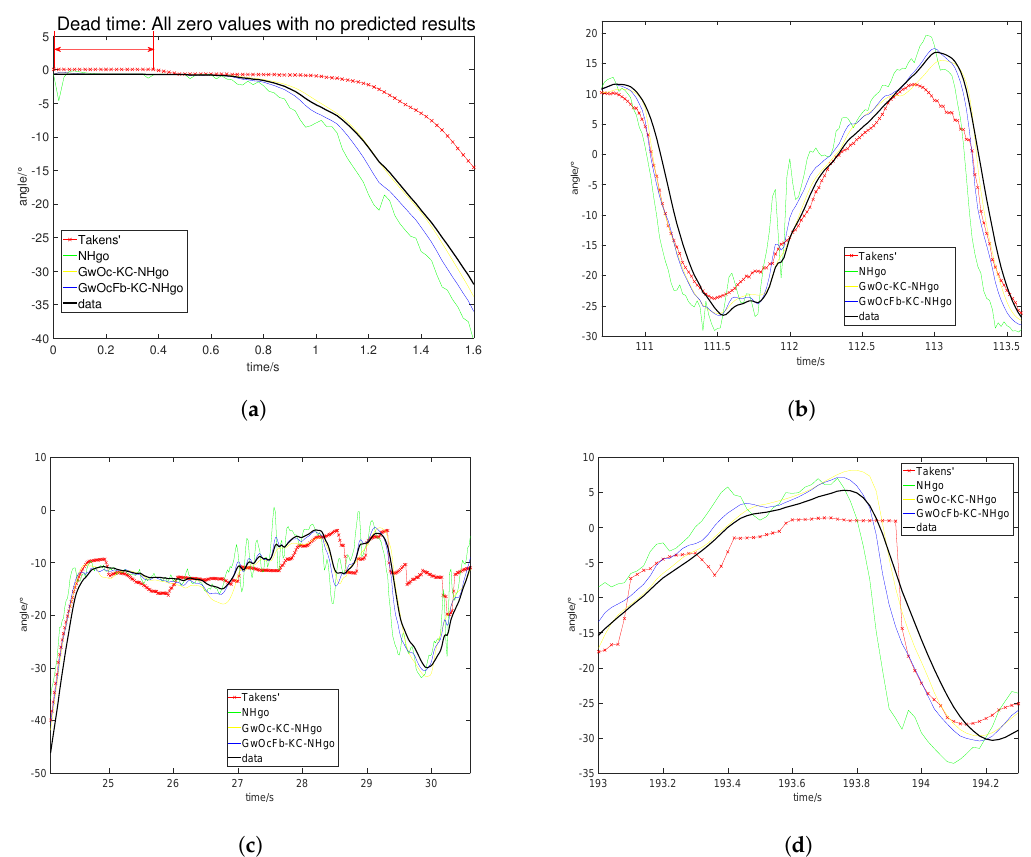
Figure 16. Typical adaptability of different methods to irregularities (left hip joint angle in sagittal plane). ( a ) Dead time during initiation; ( b ) Speed transition from 1 km/h to 2 km/h; ( c ) Stand–walk transition; ( d ) Non-periodic motion during “stopping and leaving the